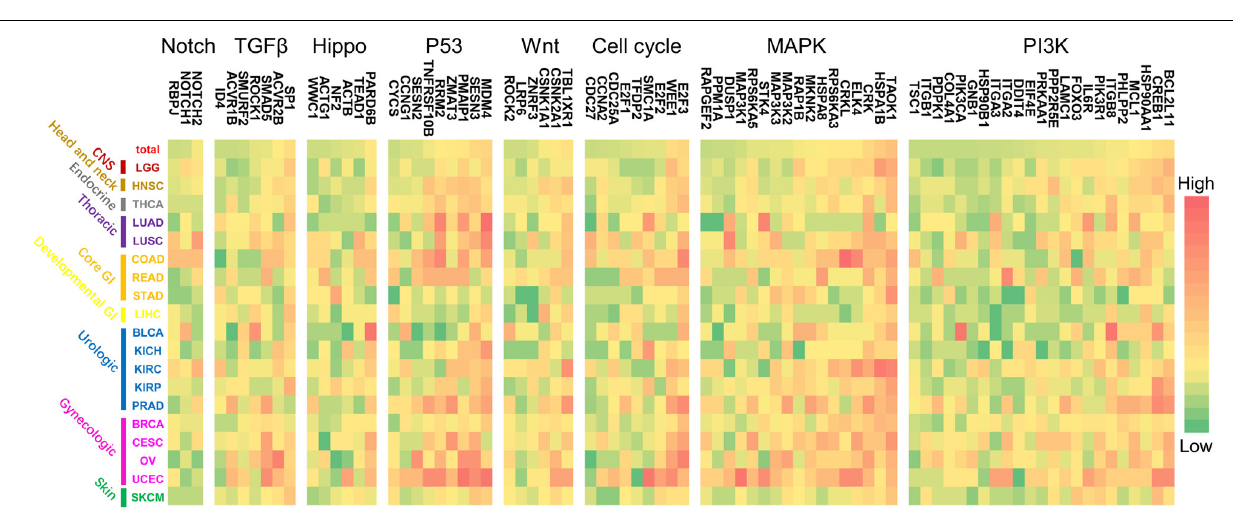
FIGURE 6 | The regulation patterns of genes in canonical pathways for multiple cancer types. For each pathway, the genes that were regulated by over 7% of the miRNA markers were illustrated. For each cancer type, different color represents the regulation percentage of corresponding miRNA